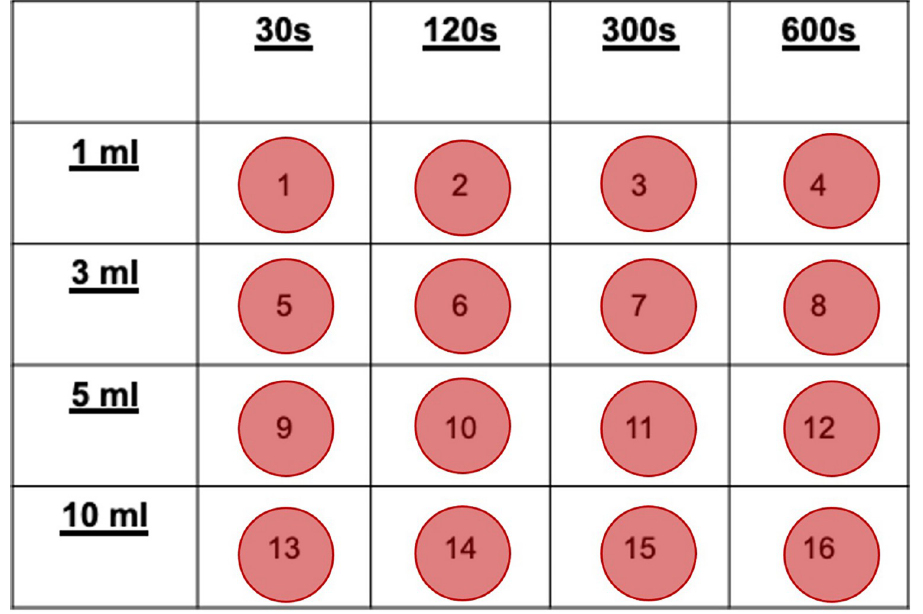
Fig 1. Grid representing plate placement for experimental procedure. Plate numbers (#1–16) were standardization across all trials. The left column indicates the volume of E . coli water applied within each row of plates. The top row indicates the time of exposure within each column of plates. The number assigned to each control plates using the random number generator followed this grid to dictate the variables to be tested in the control setting.